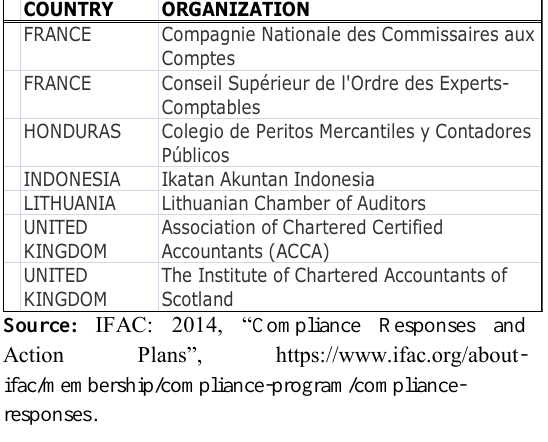
Table 4: Accounting Organizations that Have a different Approach to the Usage of IFAC Code of Ethics and Use their Own Code of Ethics COUNTRY